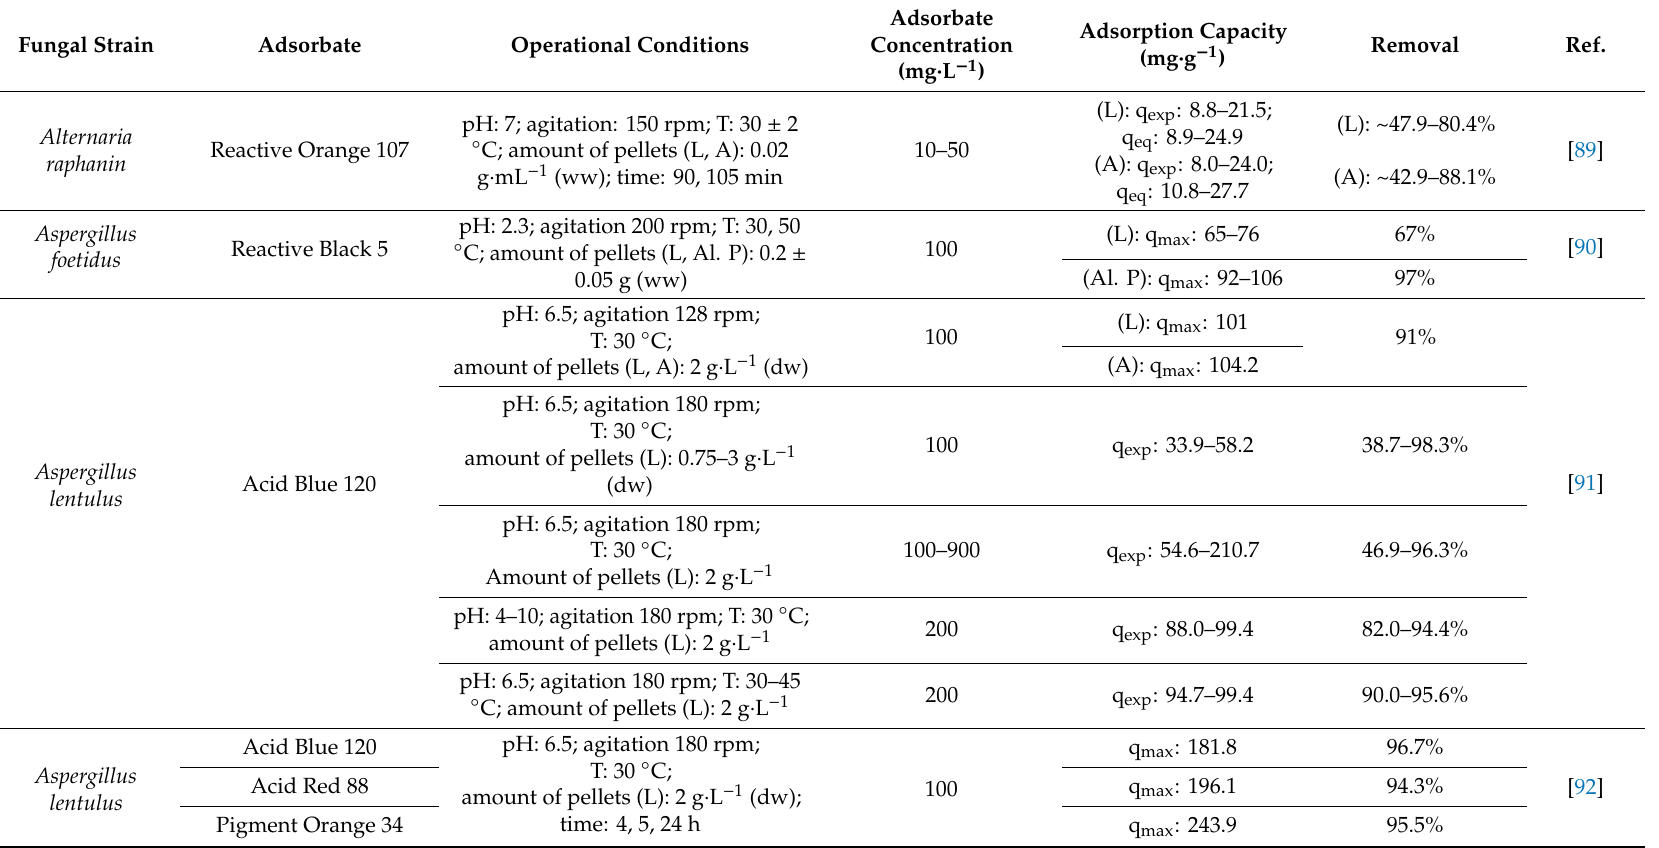
Table 3. Biosorption of dyes by fungal